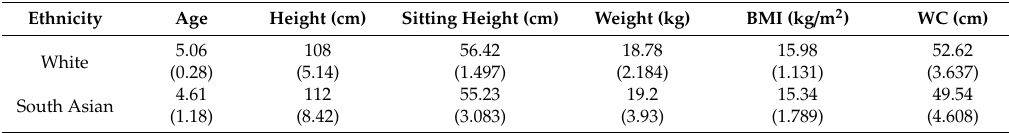
Table 2. Participant characteristics: mean